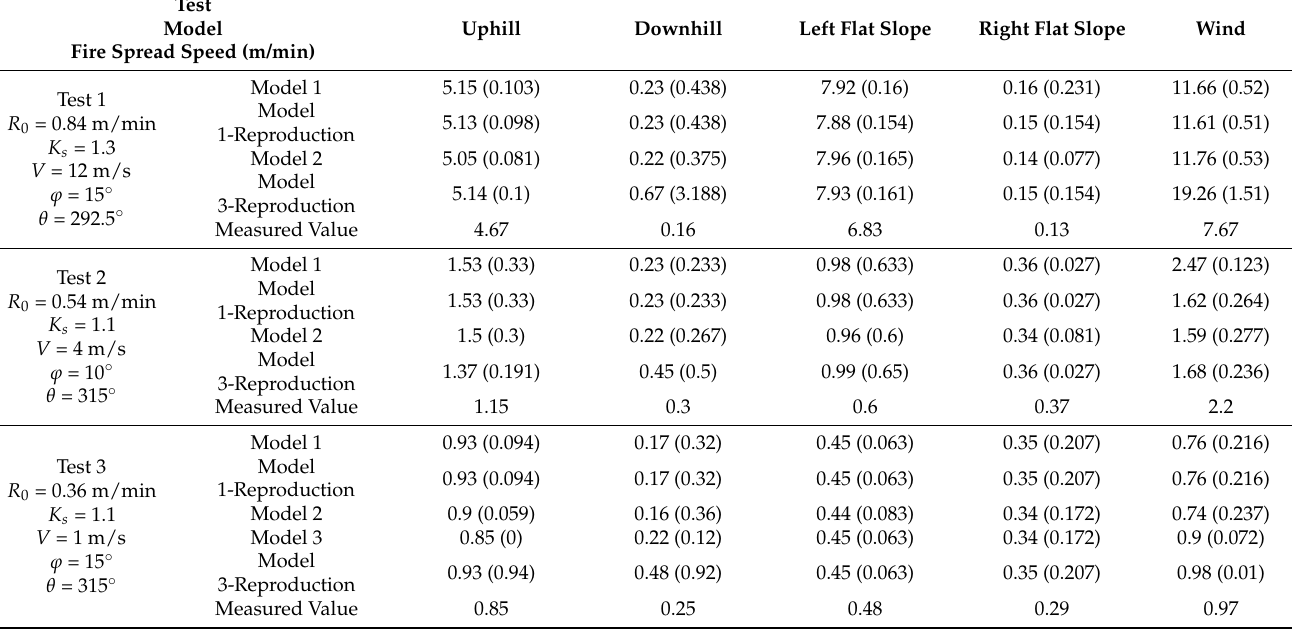
Table 3. Comparison of Results from Different Models (percentage errors are shown in